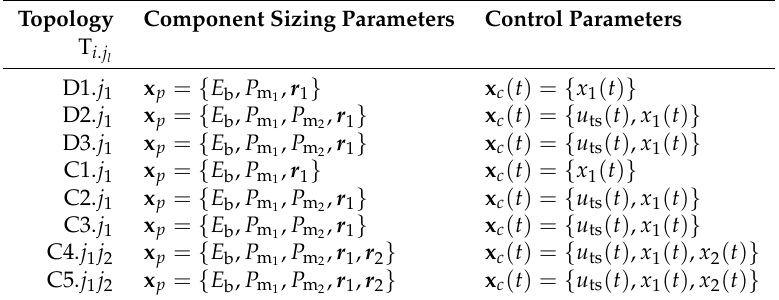
Table A1. Overview of component sizing and control design parameters per topology.